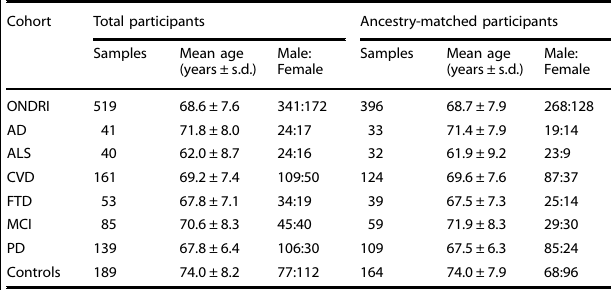
Table 1. Demographics of the total ONDRI cohorts and cognitively normal control cohort at baseline and the demographics of the cohorts following multivariate outlier